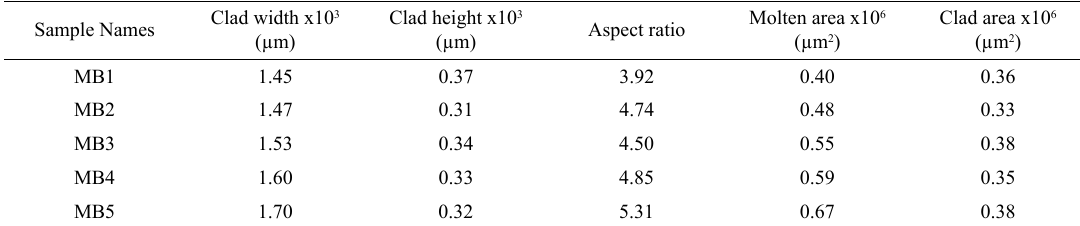
Table 4. Geometrical quantities of single laser